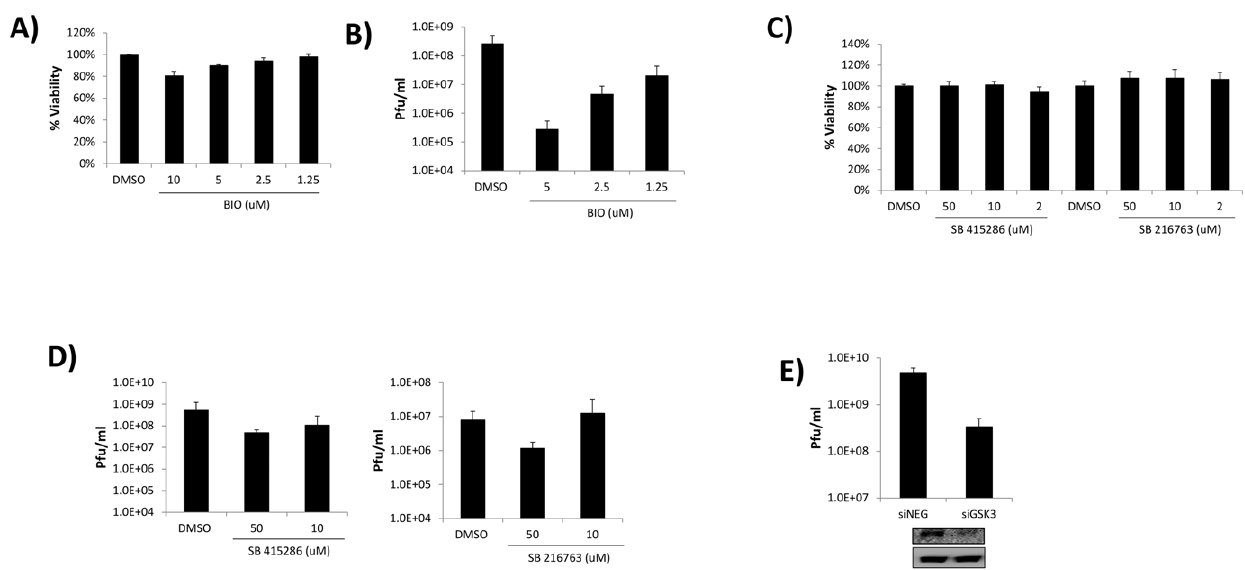
Figure 1. Small molecule inhibitors of GSK-3 b impede VEEV replication. A ) U87MG astrocytes were treated with BIO (10, 5, 2.5, or 1.25 m M) and cell viability assayed 24 hours later by CellTiter Glo Assay (Promega). DMSO treated cells are displayed at 100% viability and all treatments compared to those values. B ) U87MG astrocytes were pretreated for 2 hours with DMSO, or BIO (5, 2.5, or 1.25 m M), infected with VEEV TC-83 at MOI 0.1, and post-treated with compounds. Twenty-four hours post infection viral supernatants were collected and assayed for viral replication by